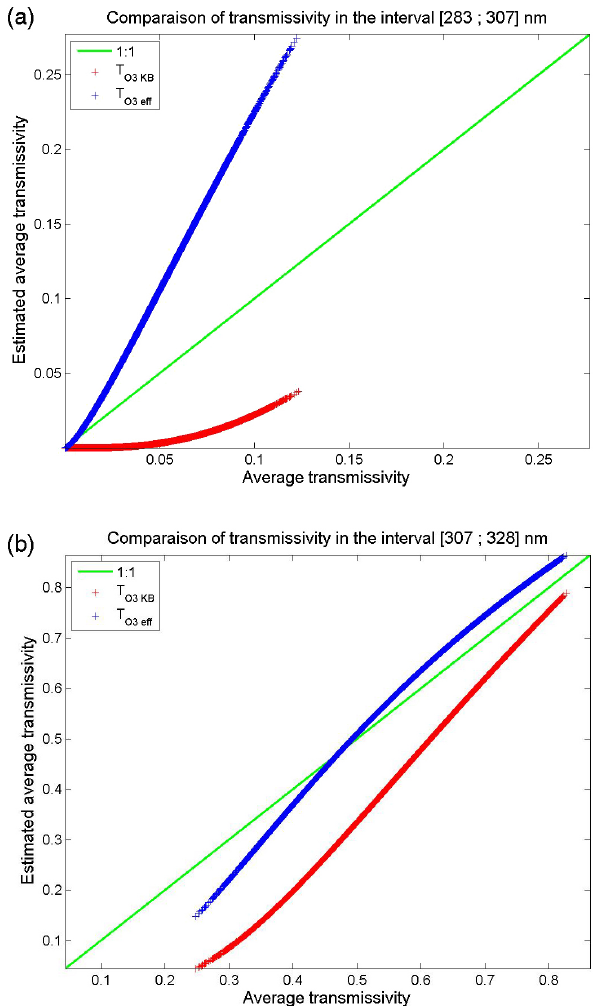
Figure 2. Scatterplot between average transmissivity T o3 (cid:49)λ and the estimated T o3 (red line) and T o3 (blue line) for (a) KB #3 [283, KB eff 307]nm and (b) KB #4 [307, 328]nm. The identity line is in